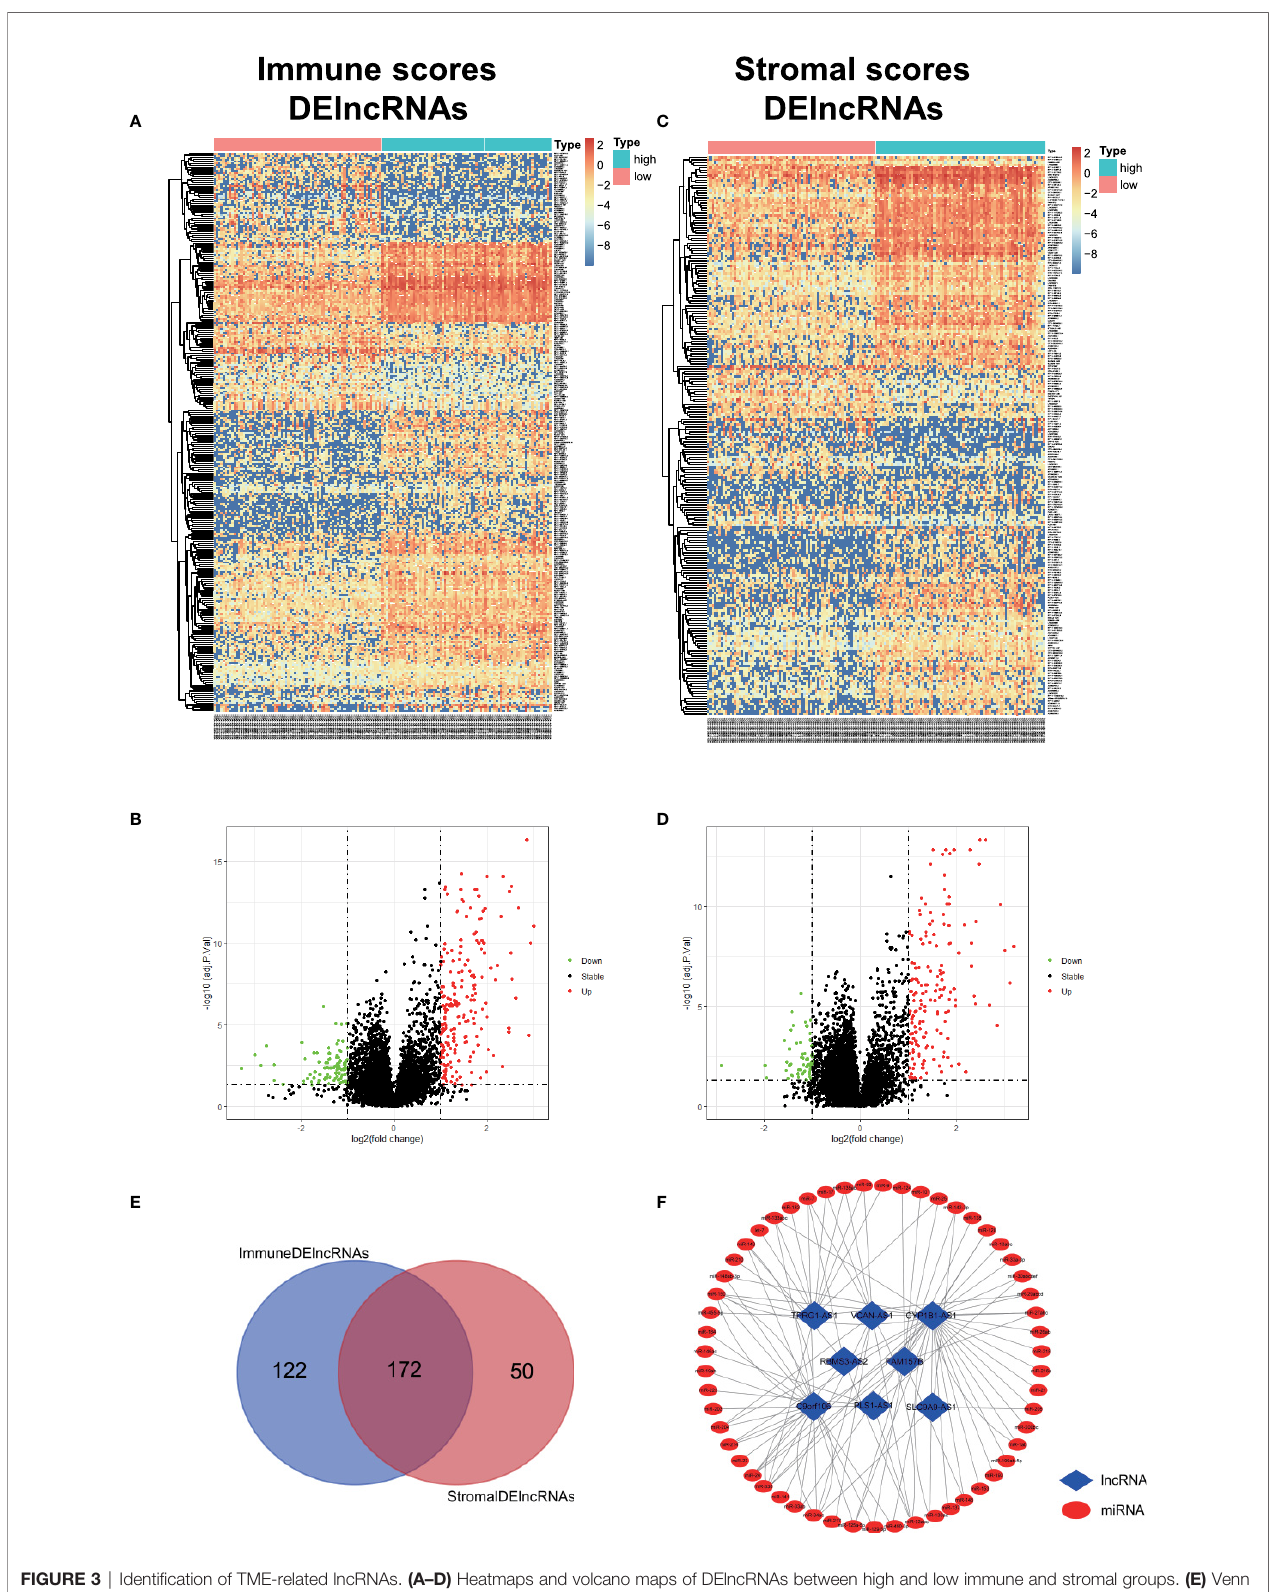
FIGURE 3 | Identi fi cation of TME-related lncRNAs. (A – D) Heatmaps and volcano maps of DElncRNAs between high and low immune and stromal groups. (E) Venn diagram was used for the intersection of DElncRNAs within immune and stromal groups, and we considered the common DElncRNAs to be TME-related mRNAs. (F) miRNAs predicted by TME-related